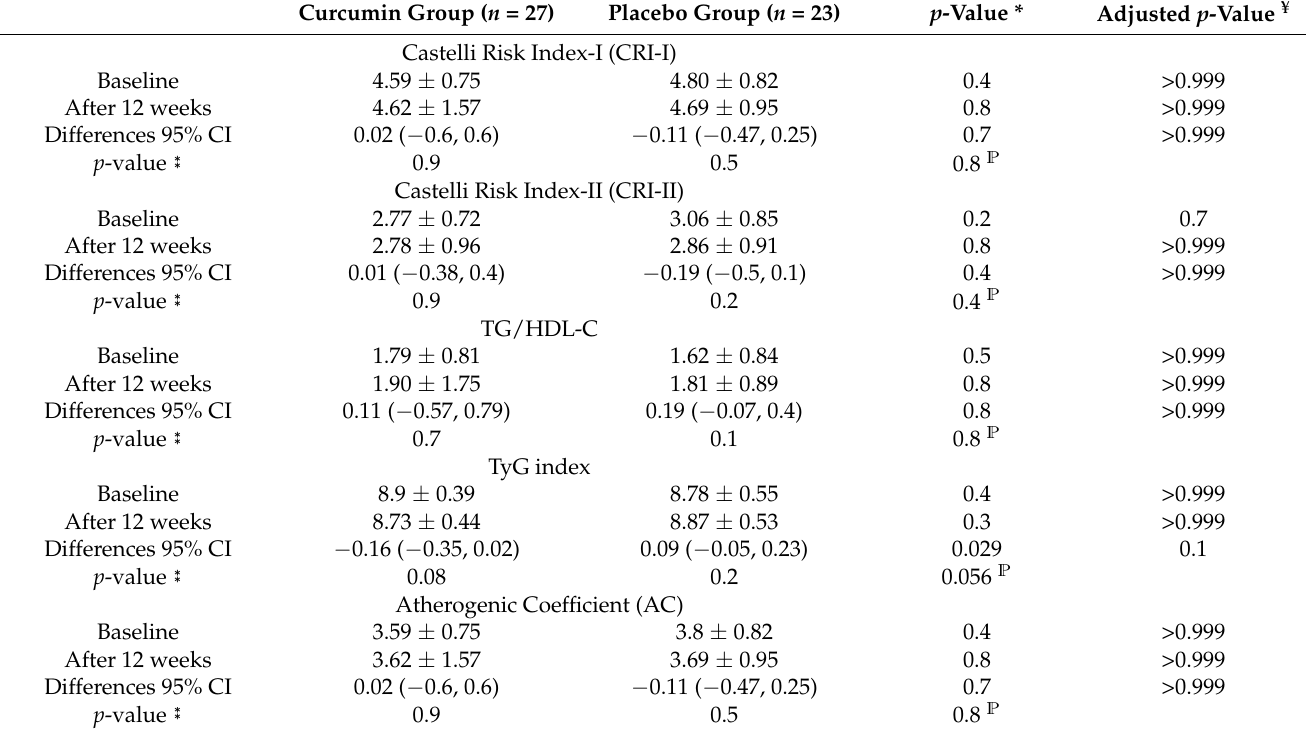
Table 2. Comparison of atherogenic indicators before and after of the trial.